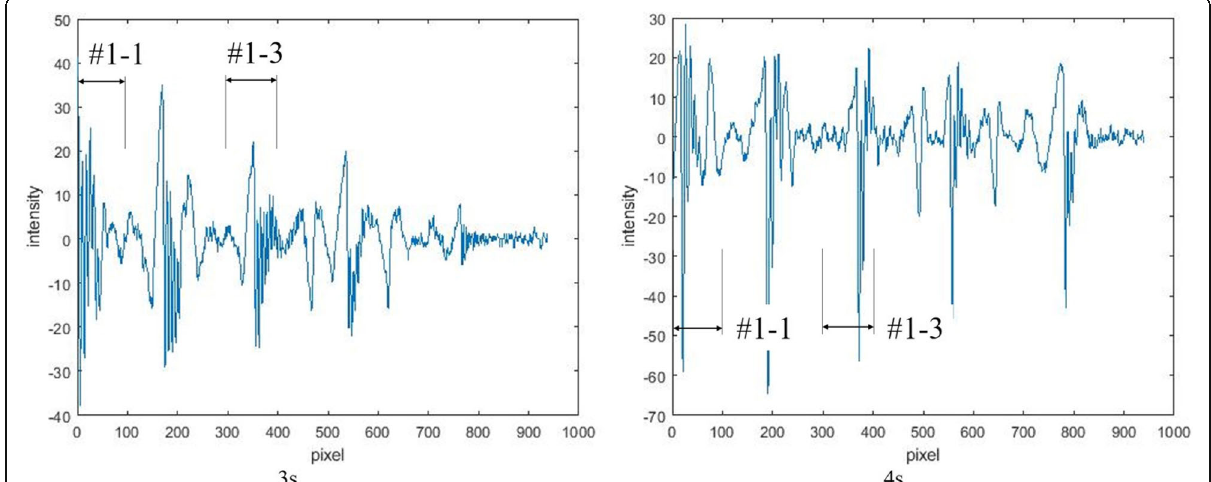
Fig. 10 Total intensity distribution at t = 3 s and 4 s for baseline case